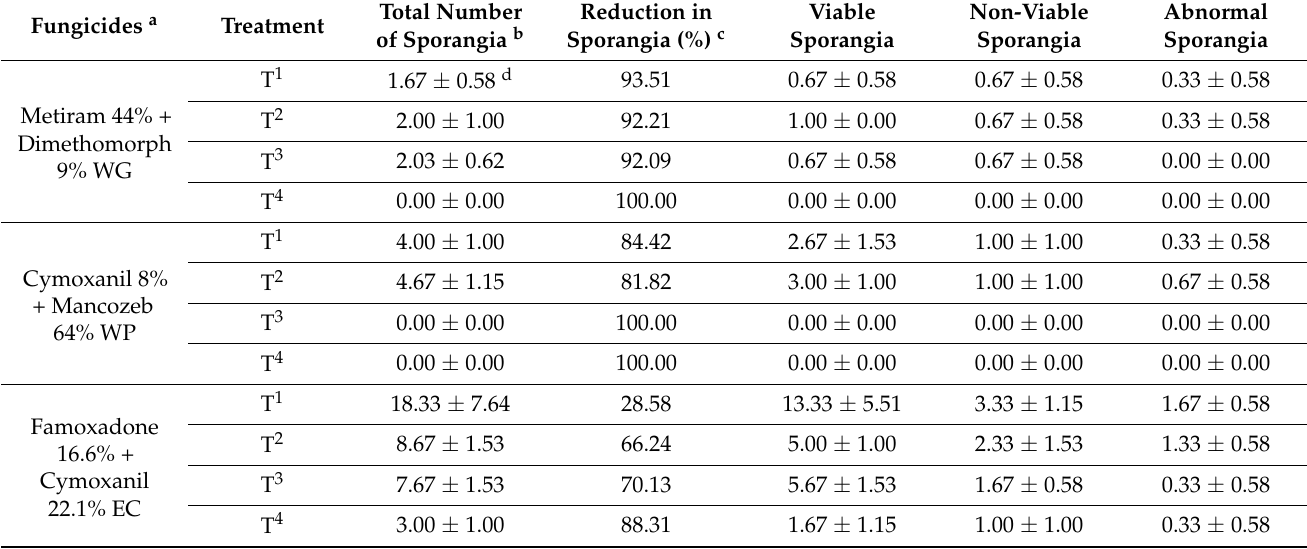
Table 2. Effect of fungicides and time of fungicide application on P. cajani sporangia development. Fungicides a Treatment